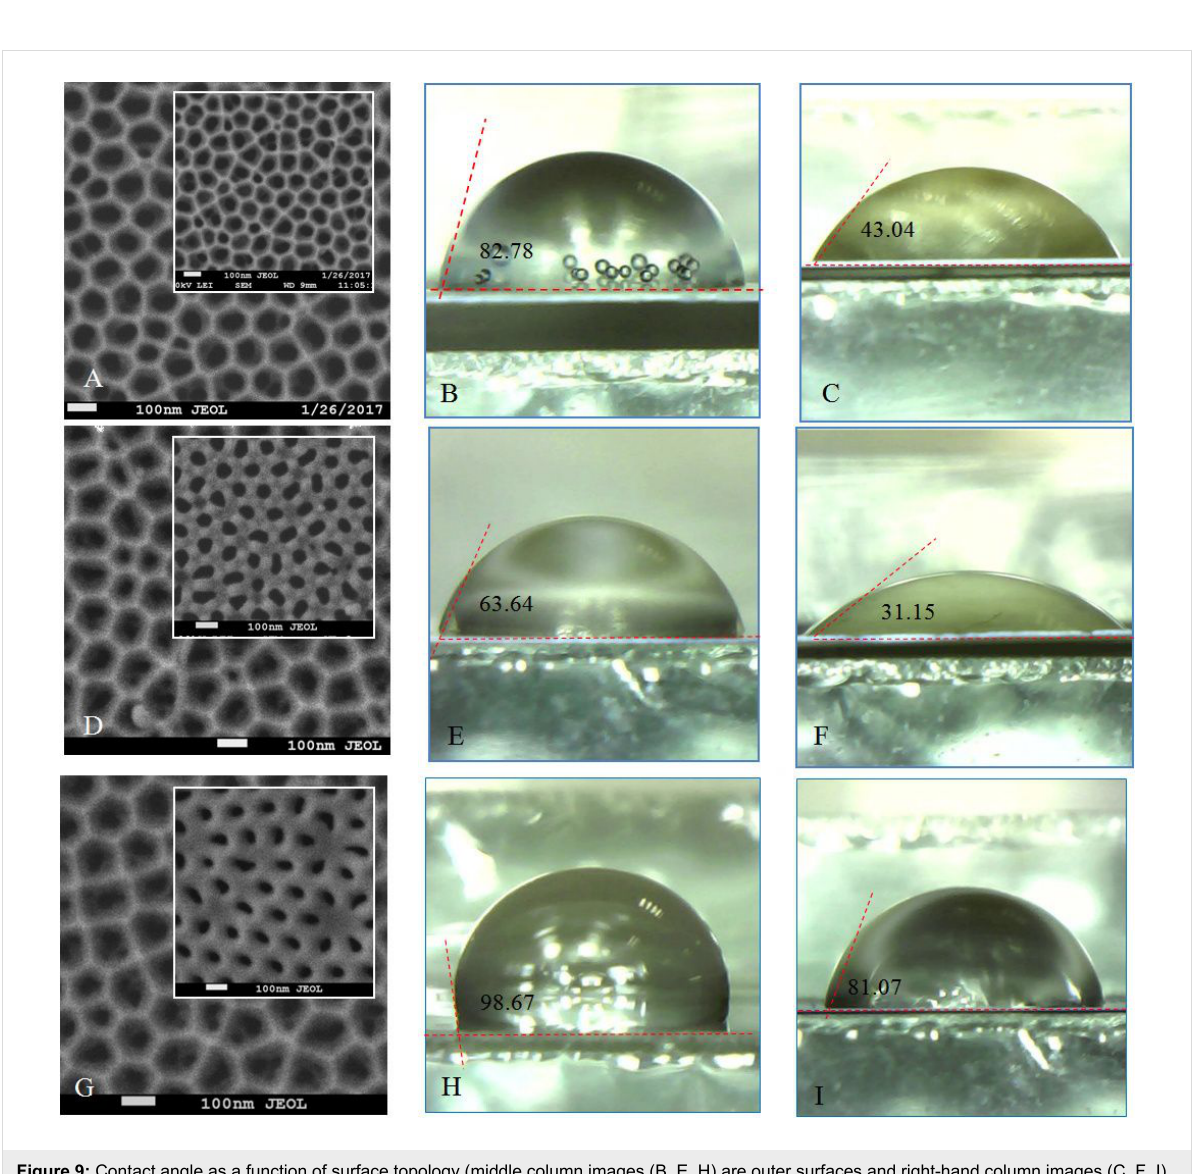
Figure 9: Contact angle as a function of surface topology (middle column images (B, E, H) are outer surfaces and right-hand column images (C, F, I) are back surfaces) for a PAM synthesized using type I synthesis conditions. (A–C) Sample 1; (D–F) sample 5 and (G–I) sample 4. (A, D, G) SEM images of outer and back (inset) surfaces of these